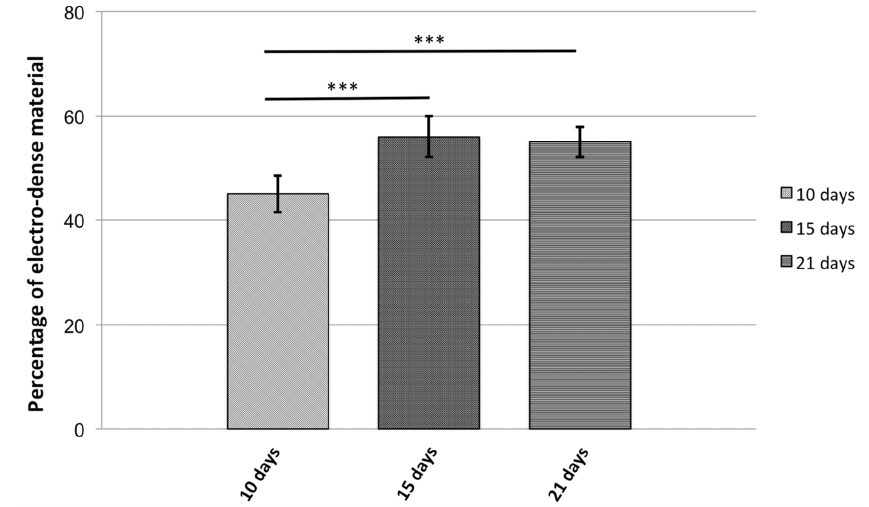
Figure 4. Nanoparticle formation in mms6-transfected MSCs. Percentage of electron-dense material present in intracytoplasmic vesicles at 10, 15, and 21 days in culture. Results are mean ± standard deviation error bars, n = 10. *** p < 0.05.